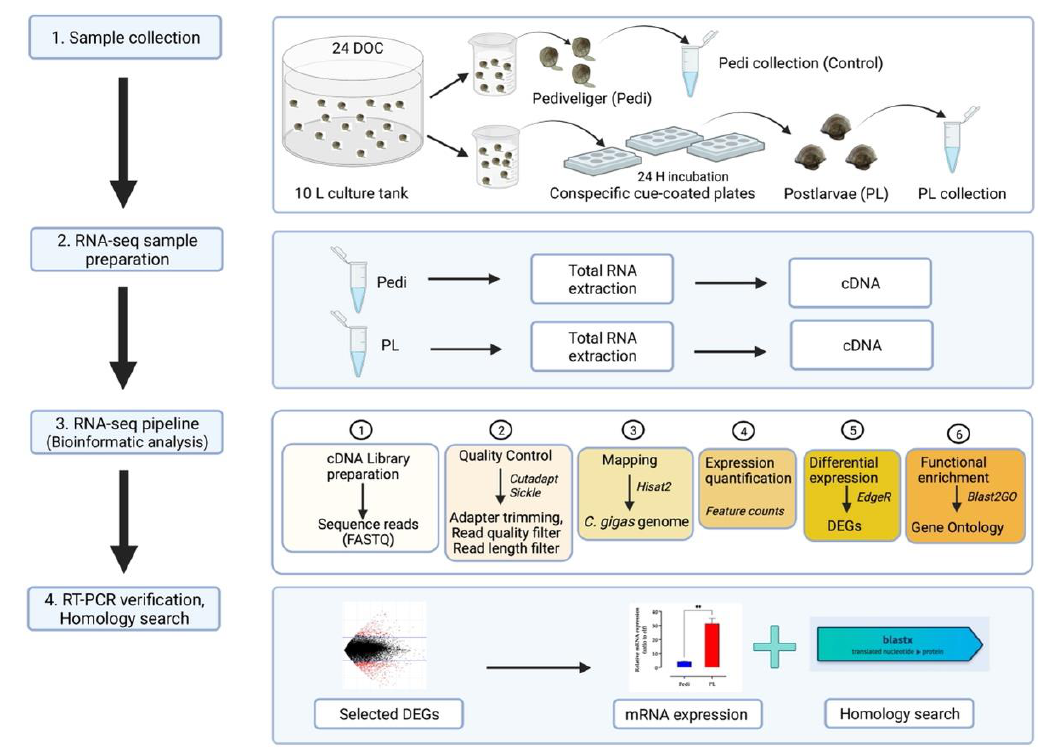
Figure 1. Research design workflow. This figure was created using BioRender.com.